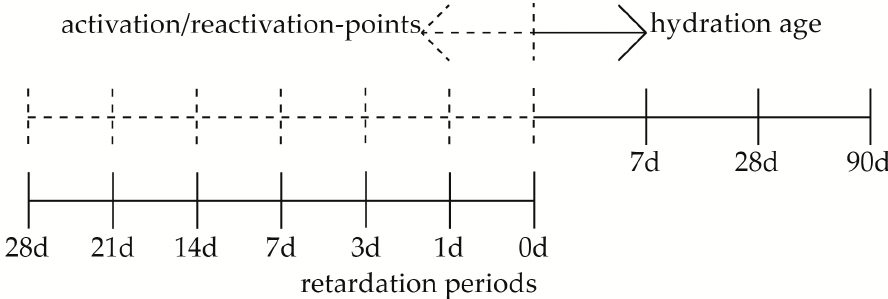
Figure 1. Timescale of the retardation periods (0–28 days), the points of activation/reactivation (Ac1, Ac2) and the ages of the hydration (7–90 days). Table 2. ( a ) Chemical composition and ( b ) physical properties of GGBFS.